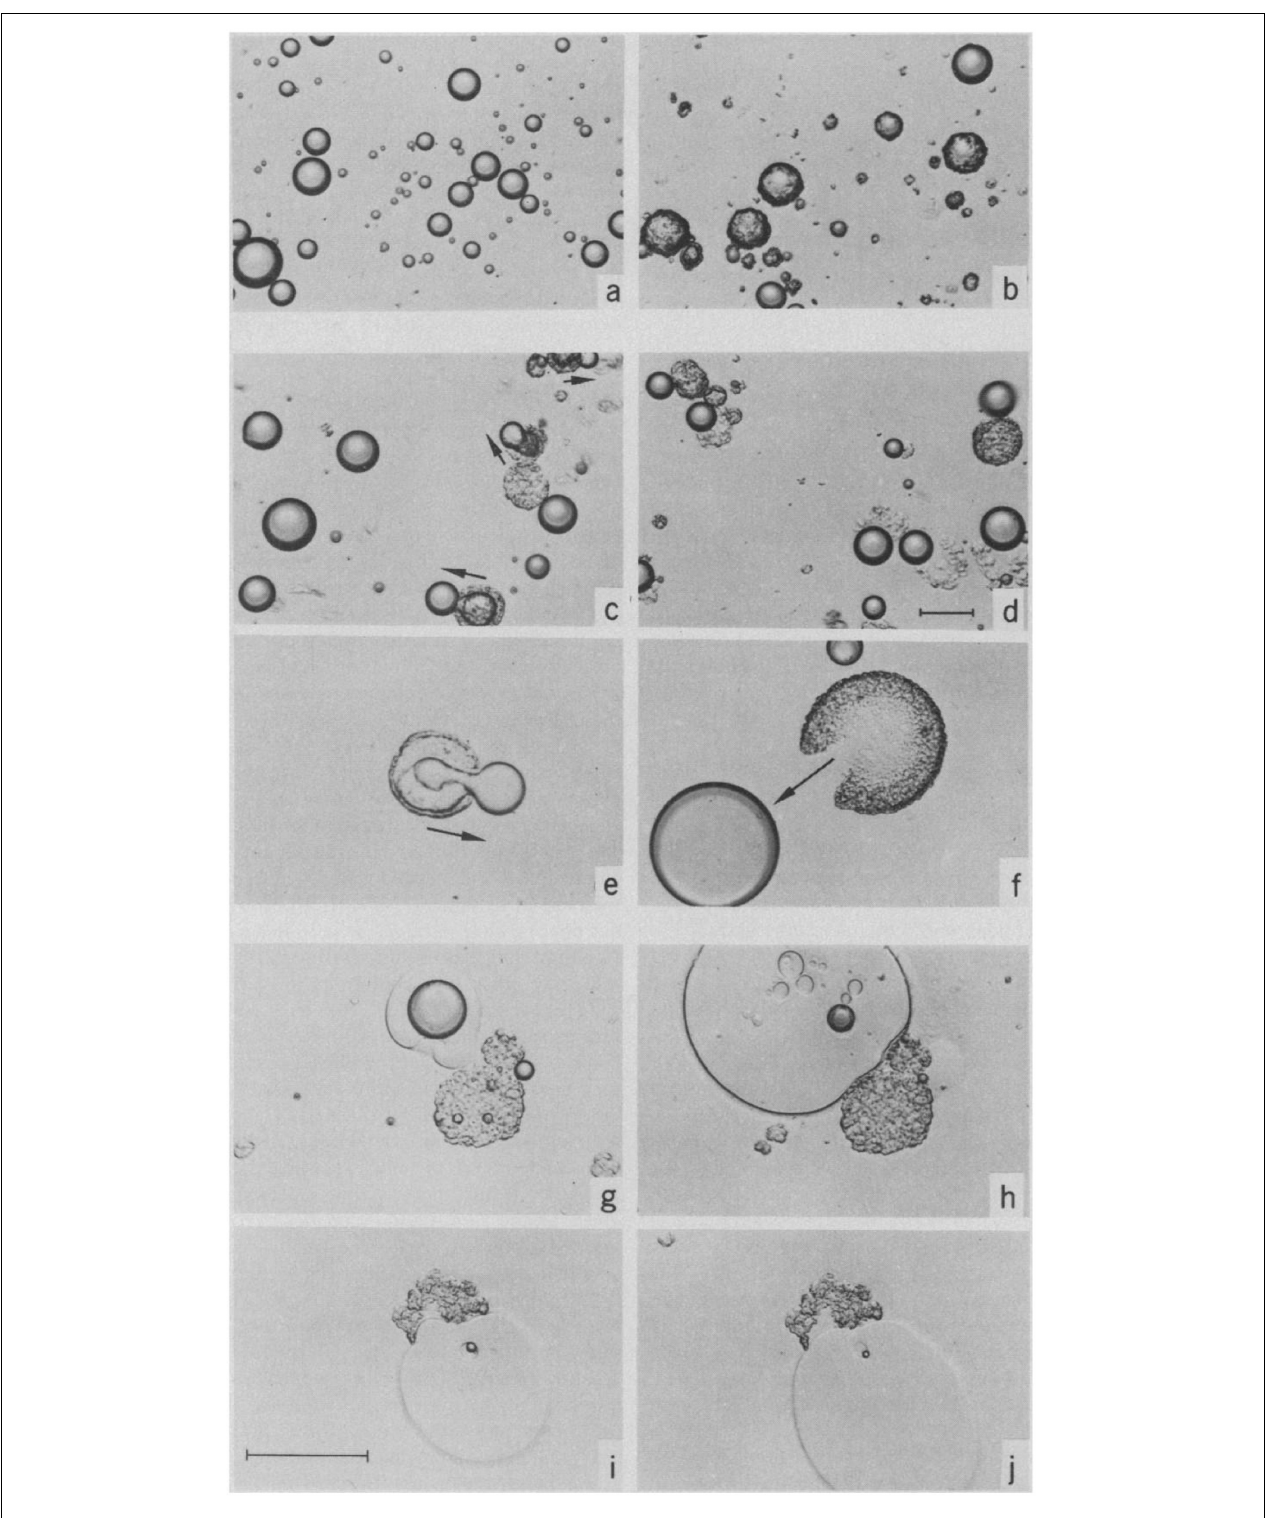
FIGURE 7 | Light microscopy images capturing the digestion process of a droplet of olive oil (Patton and Carey, 1979). Reprinted with permission from AAAS. A lamellar shell was formed following initiation of digestion (a,b) , where the shell was later broken leading to extrusion of the undigested lipids (c–f) . The presence of “viscous isotrope” phases was later observed (g–j)